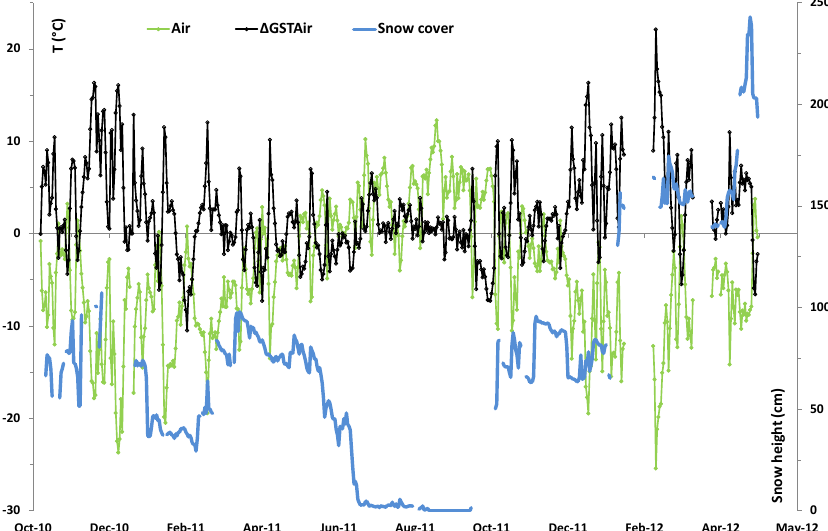
Figure 12. Effect of the snow cover at SSB. The winter 2010/11 is representative of the average conditions of the snow cover at SSB while the following season 2011/12 was the snowiest of the whole monitoring period. The difference between the daily mean GST and air temperature ( (cid:49) GSTair; black line) shows greater values during the greater drop in air temperature (green line) during the winter due to the insulating effect of the snow cover (blue line), whereas the few episodes of high (cid:49) GSTair in the summer may be due to the solar radiation that warms the ground